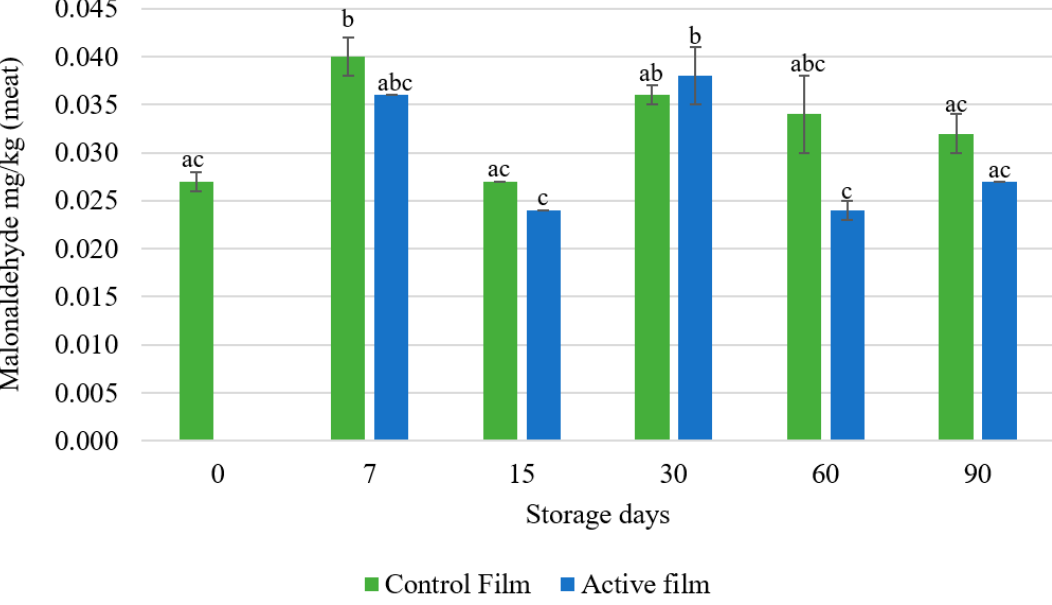
Figure 4. TBARS assay results between control and active whey protein films stored during 90 days. Control film—whey protein film without the rosemary extract; Active film—whey protein film with 1% ( w/w ) rosemary extract. Different letters represent significant differences ( p < 0.05).